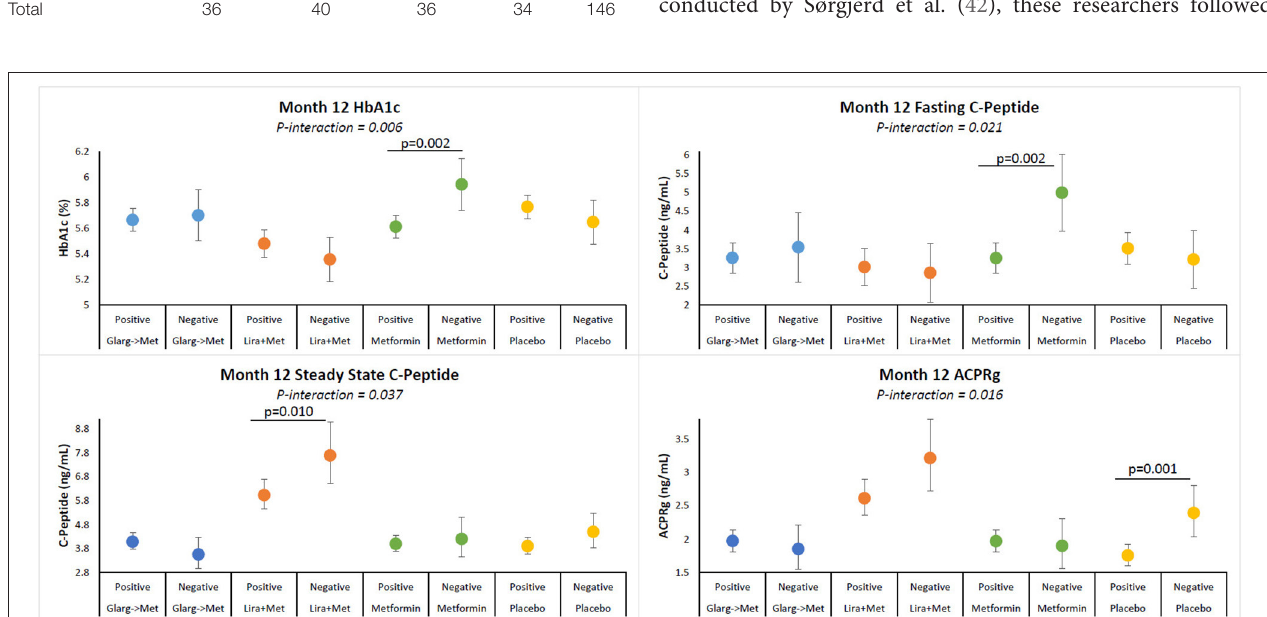
FIGURE 2 | Adjusted means of HbA1c, fasting C-peptide, SSCP, and ACPRg illustrating interactions between T cell positivity and treatment group. Participants within each treatment group are identified by colors. Participants receiving 3 months of insulin glargine followed by 9 months of metformin (blue), 12 months of liraglutide + metformin (brown), 12 months of metformin (green), or placebo (yellow). Figure shows means for values at month-12 visits. All models are adjusted for age, sex, race/ethnicity, baseline insulin sensitivity, and BMI. Positivity over 12 months: Negative results are negative at baseline and month-12 samples. Positive responses are positive at either baseline, 12 months, or baseline and month-12. P -value for comparison between autoimmune negative and positive participants.